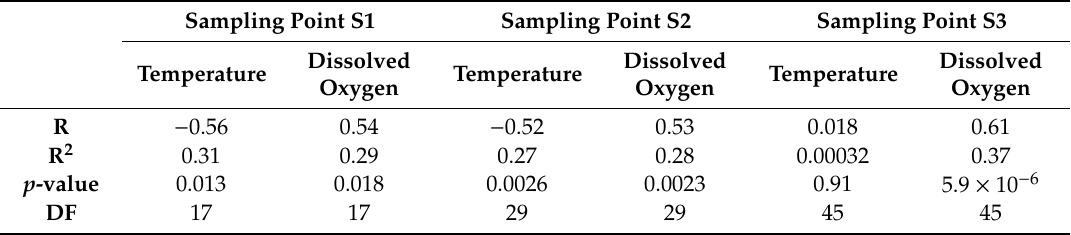
Table 2. Correlation coe ffi cients between fish density (inds. / ha) and DO (mg / L) / Temperature ( ◦ C) for the three sampling points in Lake Trichonis. Sampling Point S1 Sampling Point